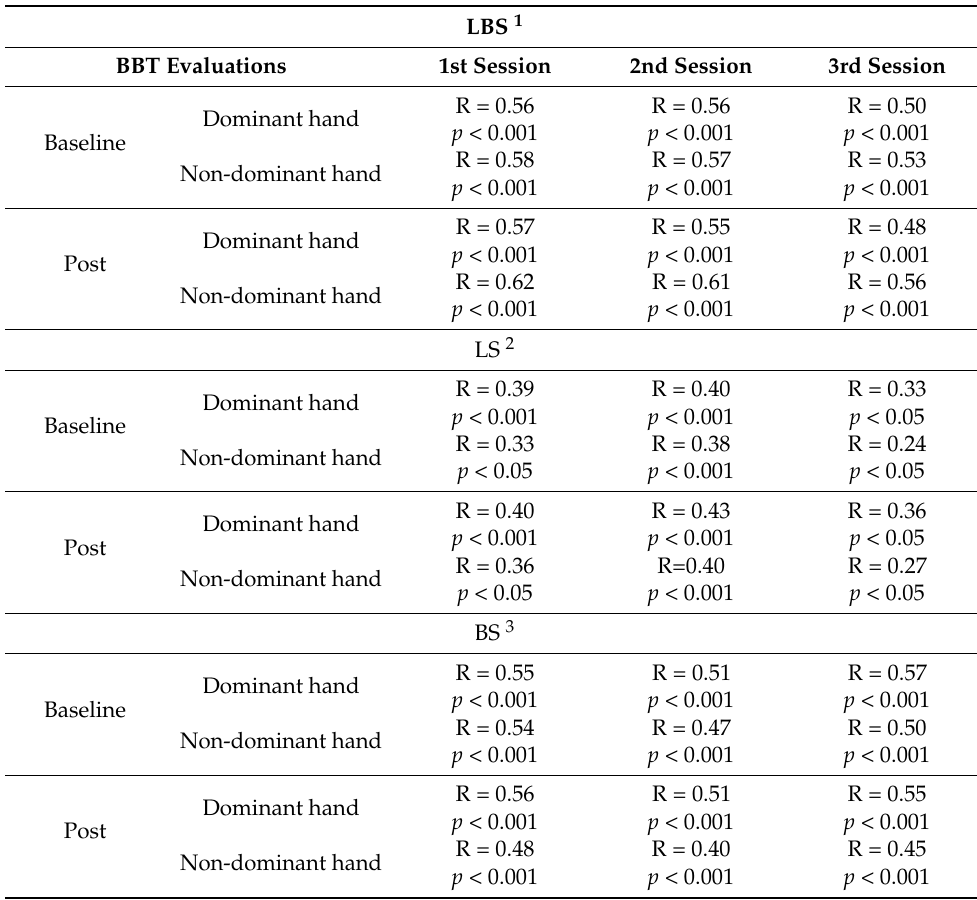
Table 15. Spearman correlation between BBT scores and TGMD-3